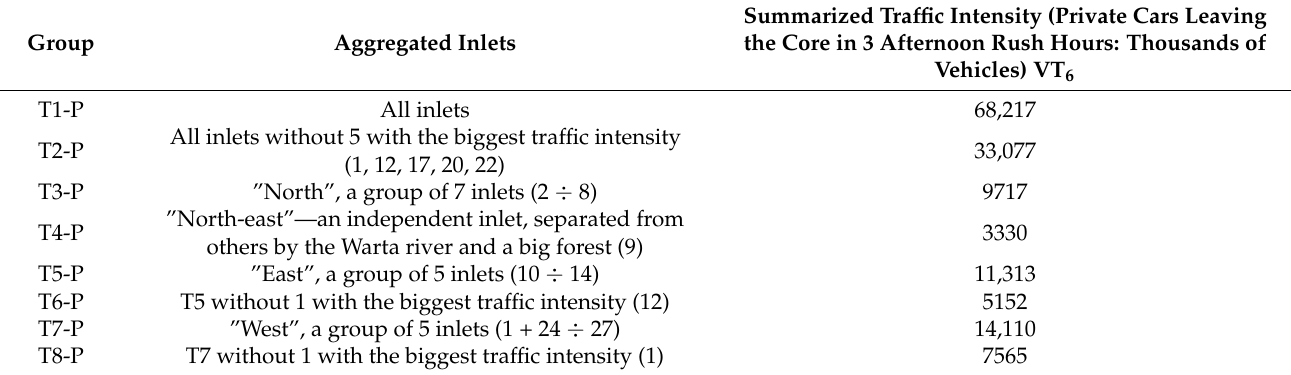
Table 14. Groups aggregating traffic parameters for the Pozna´n agglomeration in the year